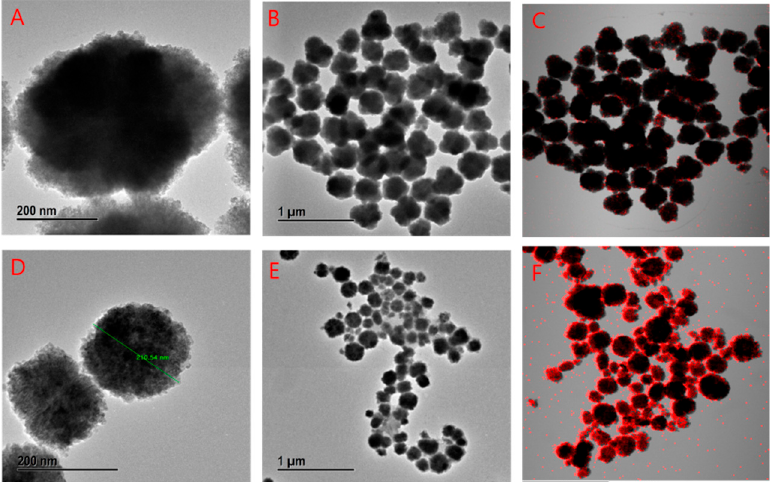
Figure 6. FE-TEM analysis of DM-ZnO nanoparticles, ( A ) multiple images at 200 nm bar range (no aggregation), ( B ) multiple images at 1 µ m bar range (no aggregation), ( C ) elemental mapping and DM-ZnO NPs, ( D ) multiple images for DM-ZnO-Try-NE at 200 nm range, ( E ) multiple images at 1 µ m bar range (no aggregation), and ( F ) elemental mapping and of DM-ZnO-Try